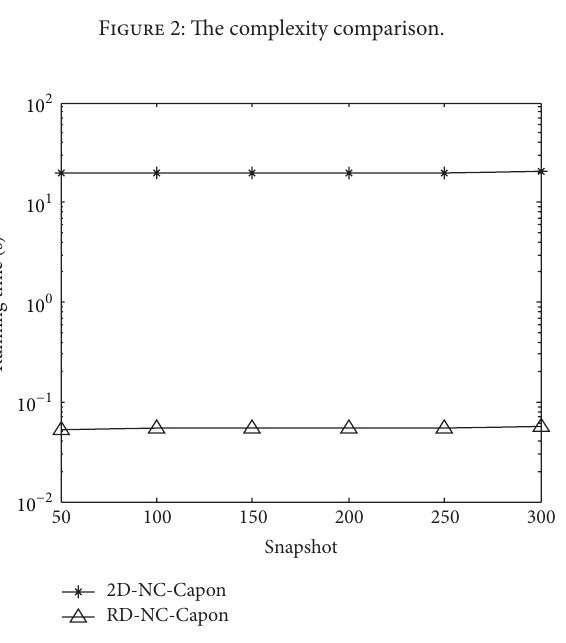
Figure 2: The complexity comparison.